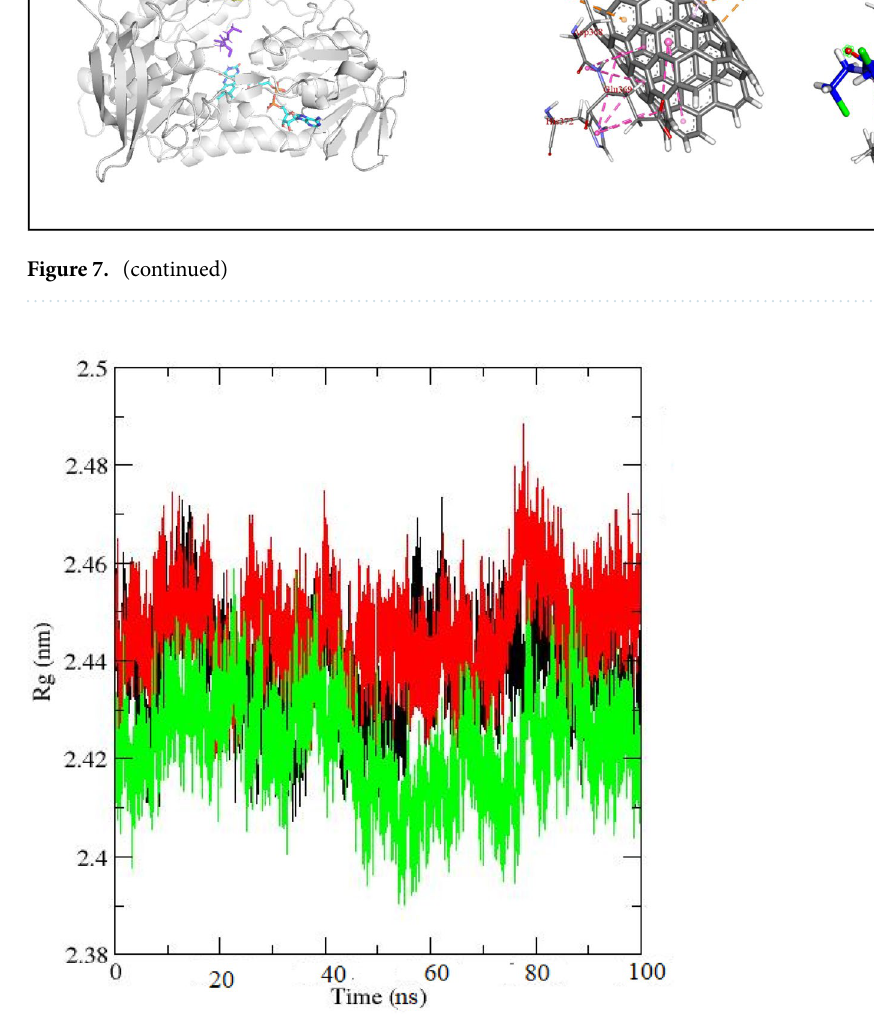
Figure 8. Radius of Gyration plot for protein (black = only GR; red = GR + FAD; green = GR + FAD + drug +